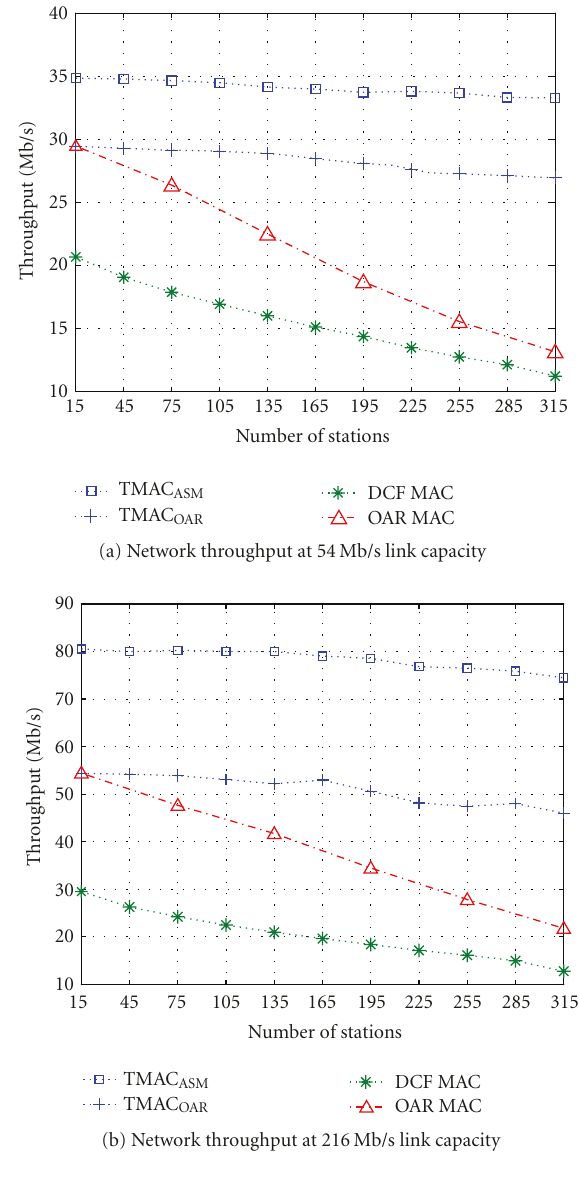
Figure 4: Network throughput versus the number of stations.